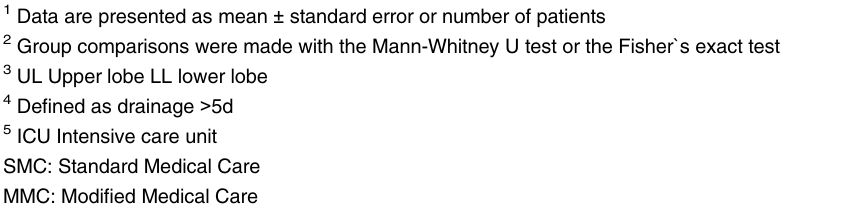
hospitalization: three SMC patients because of pneumothorax and one MMC patient because of pleural effusion and pneumonia, defined as productive coughing with pus in the sputum and administered antibiotic therapy. In both groups there were no significant differences in other complications including exacerbations defined as subjective dyspnea requiring a higher dosage of corticosteroids (p = 0.8), pneumonia (p = 0.4), pleural effusion (p = 0.8), hemoptysis (p = 0.3) and thromboembolic events (p = n.a). Although there is a significant difference in the sex ratio between the two cohorts (p = 0.01) and pneumothoraces occurred significantly more frequent in the SMC-cohort (p = 0.02) there was no significant association between the sex ratio and the occurrence of pneumothoraces in our study cohort (p = 0.7). In order to adjust for a possible influence of gender on the occurrence of pneumothorax we performed a logistic regression analysis with the factors study group and gender. Again, gender had no significant effect on the occurrence of pneumothorax following ELVR (p = 0.9) whereas the SMC and MMC factor remained significant in the regression analysis (p = 0.02).